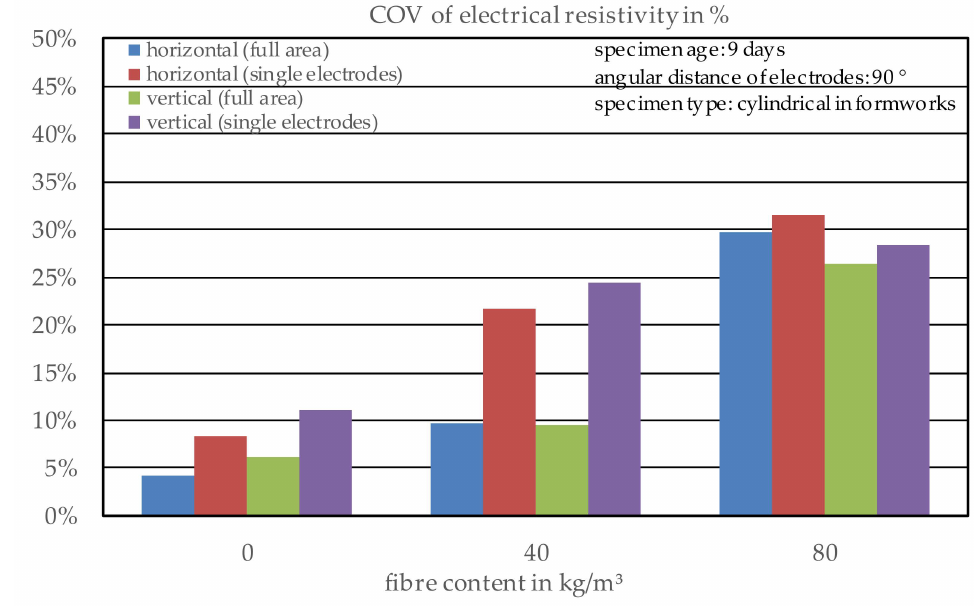
Figure A3. Coefficient of variation of the electrical resistivity in different directions depending on the fibre content at a specimen age of 9 days and an electrode array with angular distances of 90 ◦ .